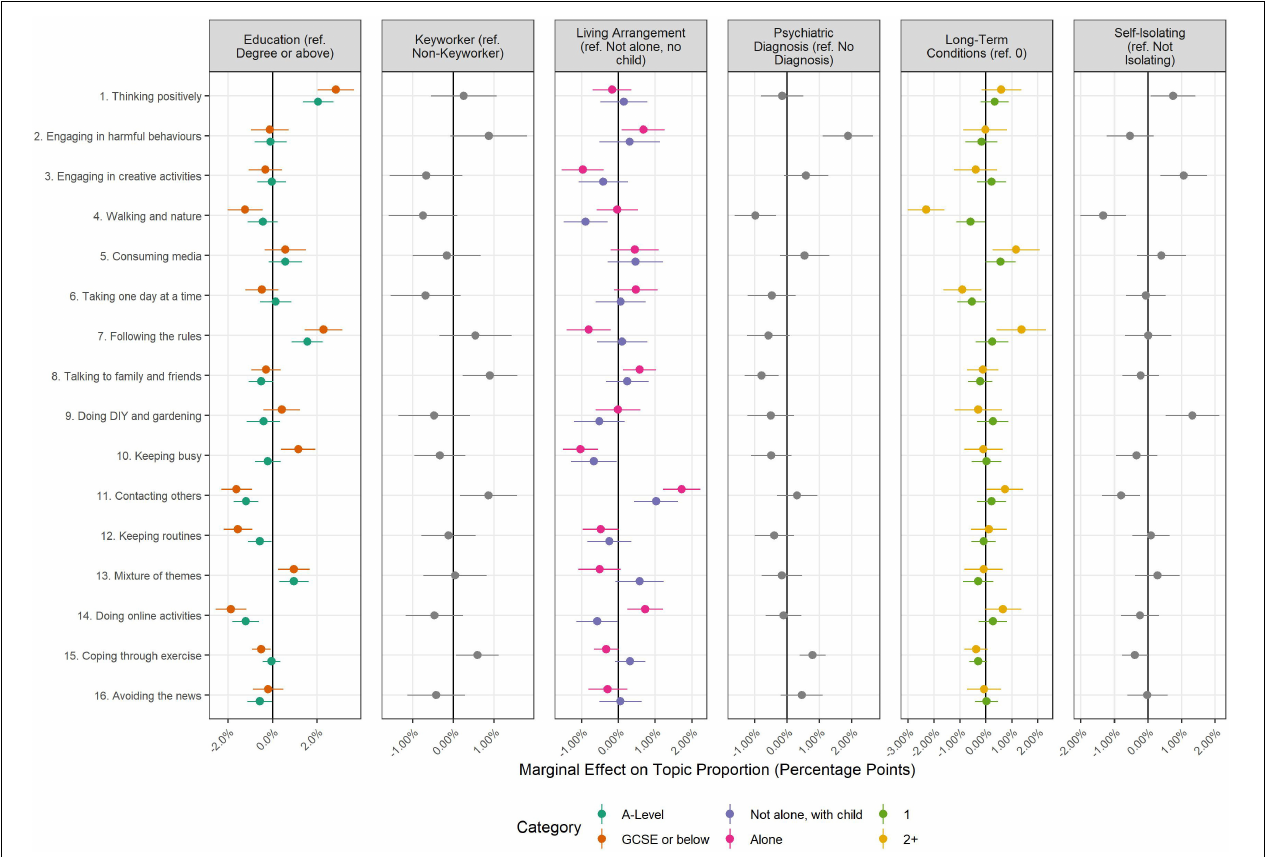
FIGURE 5 | Association between document topic proportion and participants’ socioeconomic and health characteristics (+95% confidence intervals). Results displayed as marginal effects (difference in topic proportion according to change in independent variable). Derived from OLS regression models including adjustment for gender, ethnicity, age, education level, living arrangement, psychiatric diagnosis, long-term physical health conditions, self-isolation status, Big-5 personality traits and keyworker status. Reference categories are provided in the plot